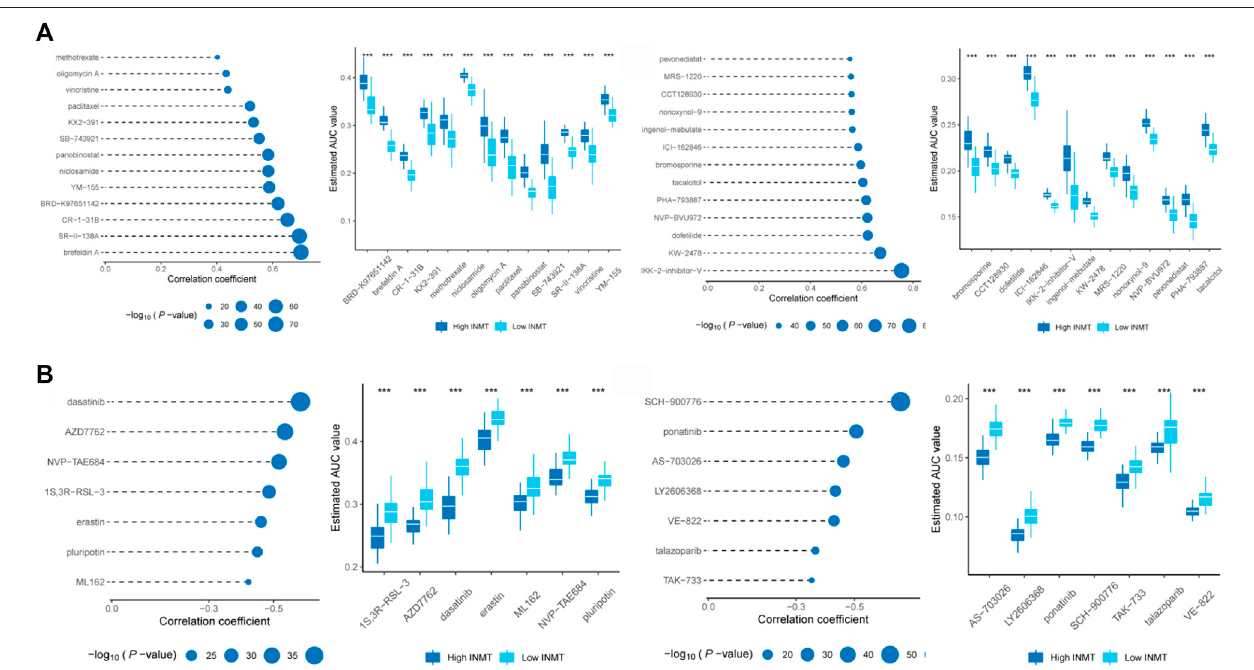
FIGURE6| Identi fi cationofcandidateagentswithhighdrugsensitivityinpatientgroupswithvariousINMTexpressionlevels.BasedonCTRPandPRISMdatasets, (A) Spearman correlation analysis found that the AUC values of 26 compounds were positively correlated with the expression of INMT, (B) while the AUC values of 14 compounds were negatively correlated with the expression of INMT. Note that the lower the value on the Y-axis of the box plot, the higher the drug sensitivity.